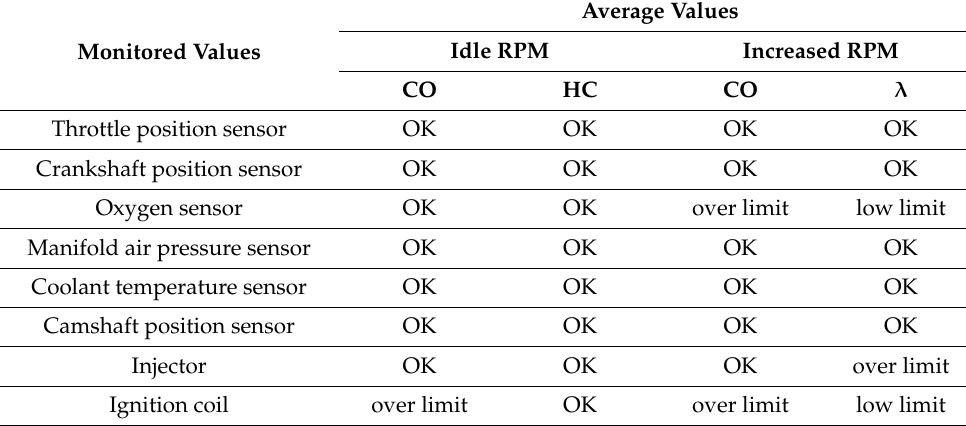
Table 6. Emissions measured during disconnection of monitored components (author).